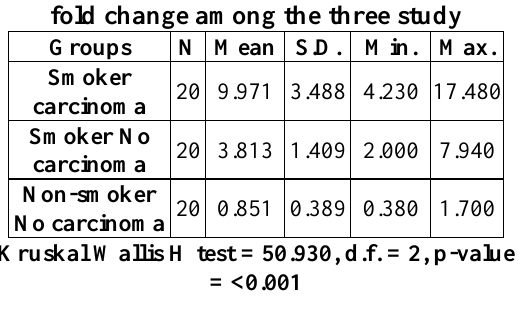
Table 2: Statistical differences among the study